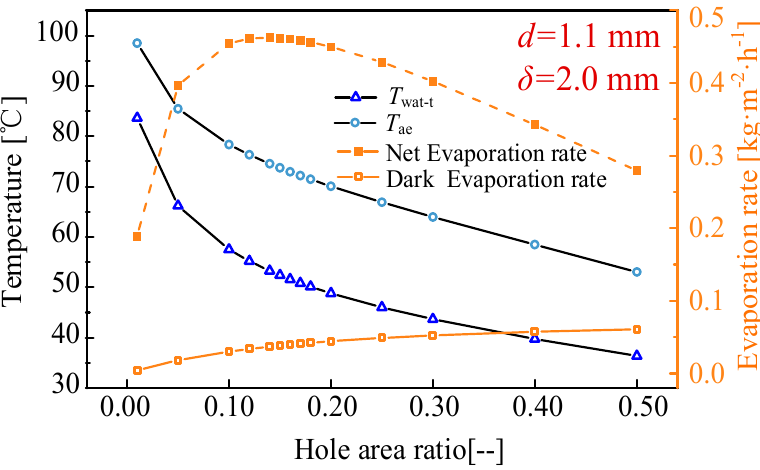
Figure 8. T ae , T wat-t and evaporation rate under different hole area ratios, with the same hole diameter ( d = 1.1 mm) and air layer thickness ( δ = 2.0 mm).